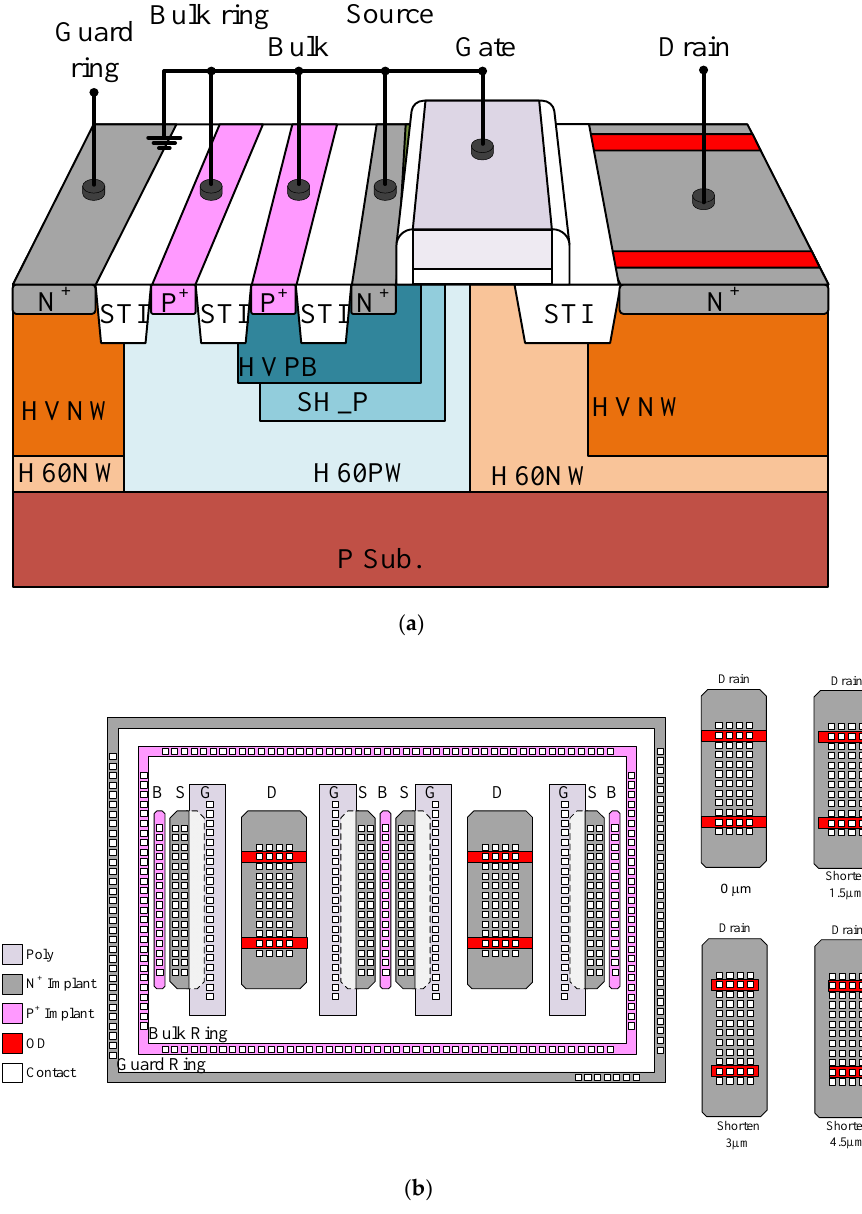
Figure 4. ( a ) 3D structure view and ( b ) layout diagram of the HV nLDMOS with the drain electrode-embedded horizontal Schottky length modulation. Table 2. Area ratios of N + and Schottky diode regions in the drain electrode.